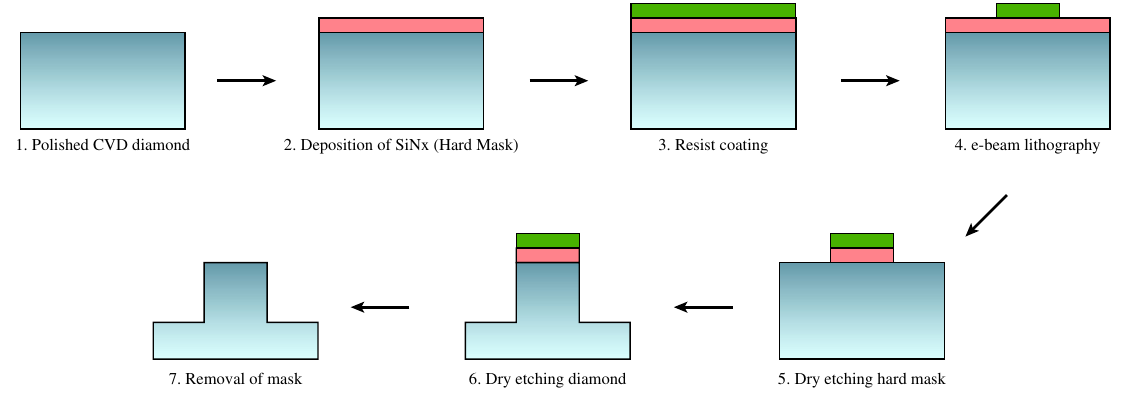
FIG. 6. Fabrication steps. Dry-etching fabrication process of diamond